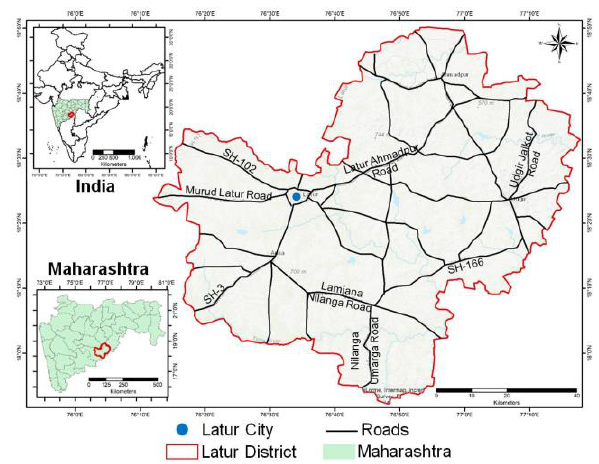
Figure 1. Study area showing Latur district in Maharashtra state of India.